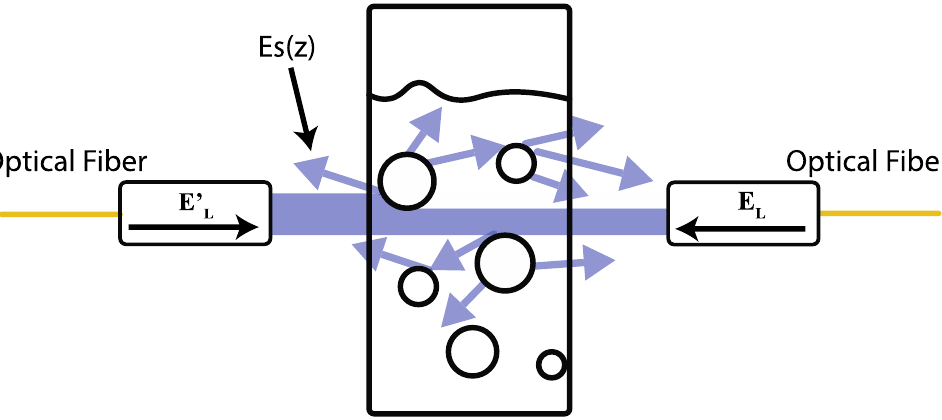
Figure 3. Visual representation of the incident and scattered beams through the milk sample into the quartz cell.